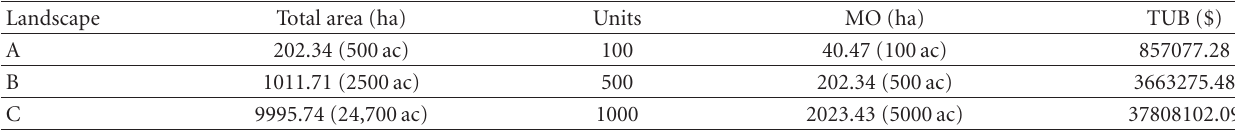
Table 2: Description of simulated landscapes; MO stands for minimal acres required to be in old-growth patches of a minimum size and TUB represents the nonspatial trivial upper bound as estimated using GAMS.